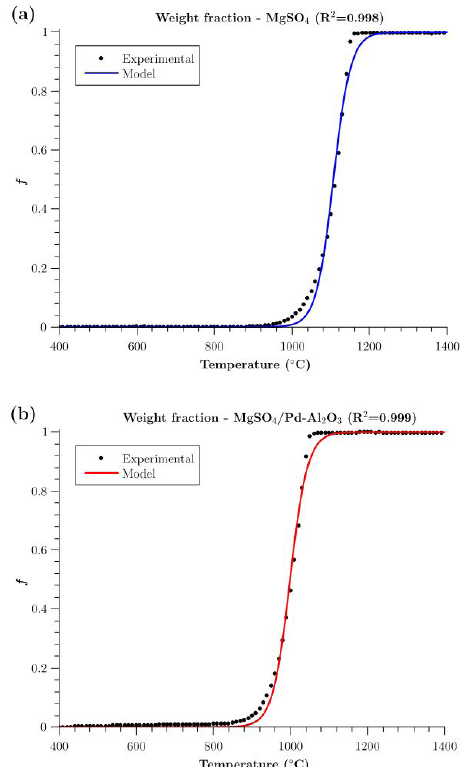
Figure 10. Experimental and sigmoidal approximation values of the weight fraction: (a) MgSO Pd/Al O . 2 3